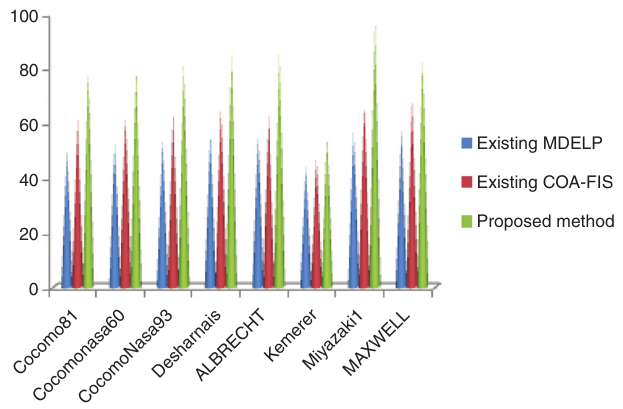
Figure 4: Prediction Comparison between the Existing and Proposed